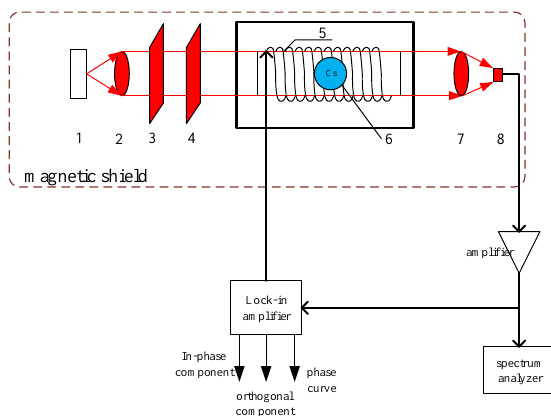
Figure 7. Experiment setup of magnetometer: ( 1 ) lamp, ( 2 ) lens, ( 3 ) filter, ( 4 ) polarizer, ( 5 ) rf coil, ( 6 ) cell, ( 7 ) lens, ( 8 ) photo detector.